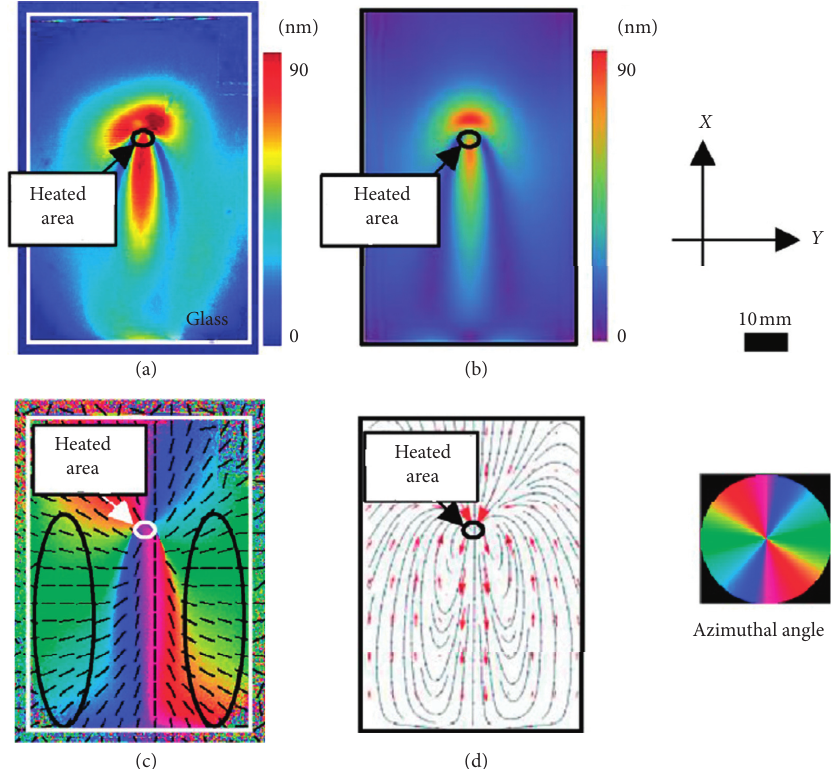
Figure 4: Measured and calculated results of birefringence retardation and azimuthal angle near the center of the glass [25]. (a) The measured result of birefringence retardation, (b) calculated result of birefringence retardation, (c) measured result of azimuthal angle, and (d) calculated result of azimuthal